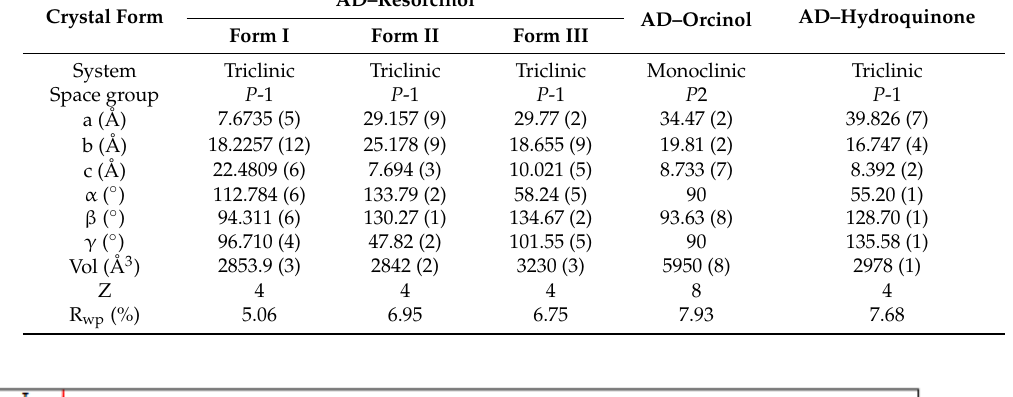
Table 2. Comparative crystallographic data from XRPD of AD cocrystals at 298 K.